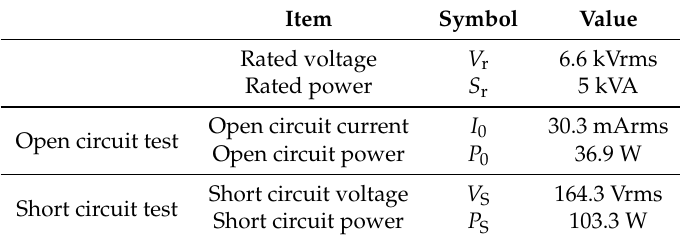
Table 1. Test data for single-phase distribution transformer in Figure 1 on PSIM